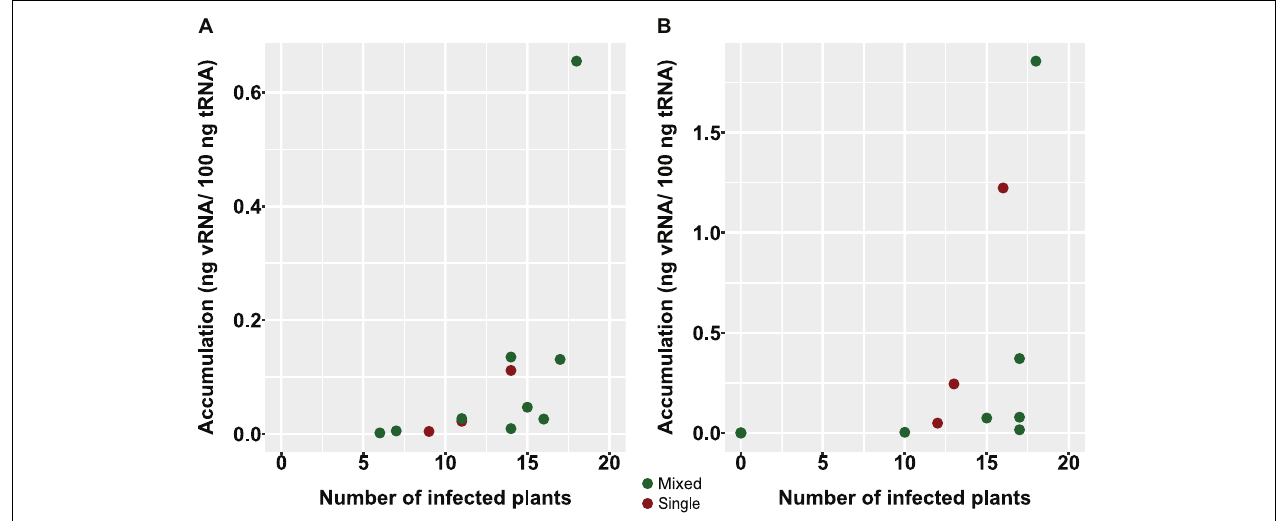
FIGURE 4 | Effect on PepMV mechanical transmission of virus accumulation in source plants. Scatter plots of viral accumulation in source plants, measured by absolute RT-qPCR and shown as ng viral RNA/100 ng total RNA, and efficiency of transmission, measured by the number of infected plants with PepMV-EU (A) or PepMV-CH2 (B) . Five tomato plants were used as the source of inoculum, including two single infections, one simultaneous mixed infection, and two over infections. Viral load in inocula ranged from 0.05 to 0.66 ng vRNA/100 ng total RNA for PepMV-EU and 2.75E-5 to 1.86 ng vRNA/100 ng total RNA for PepMV-CH2. Undiluted and two dilutions (1:5 and 1:25) of inocula were used to mechanically inoculate 54 plants per treatment. The type of infection was determined for each plant by specific tissue-print hybridization at 10 days after inoculation. Inocula from single and mixed infections (simultaneous or over-infections) are marked in red or green,